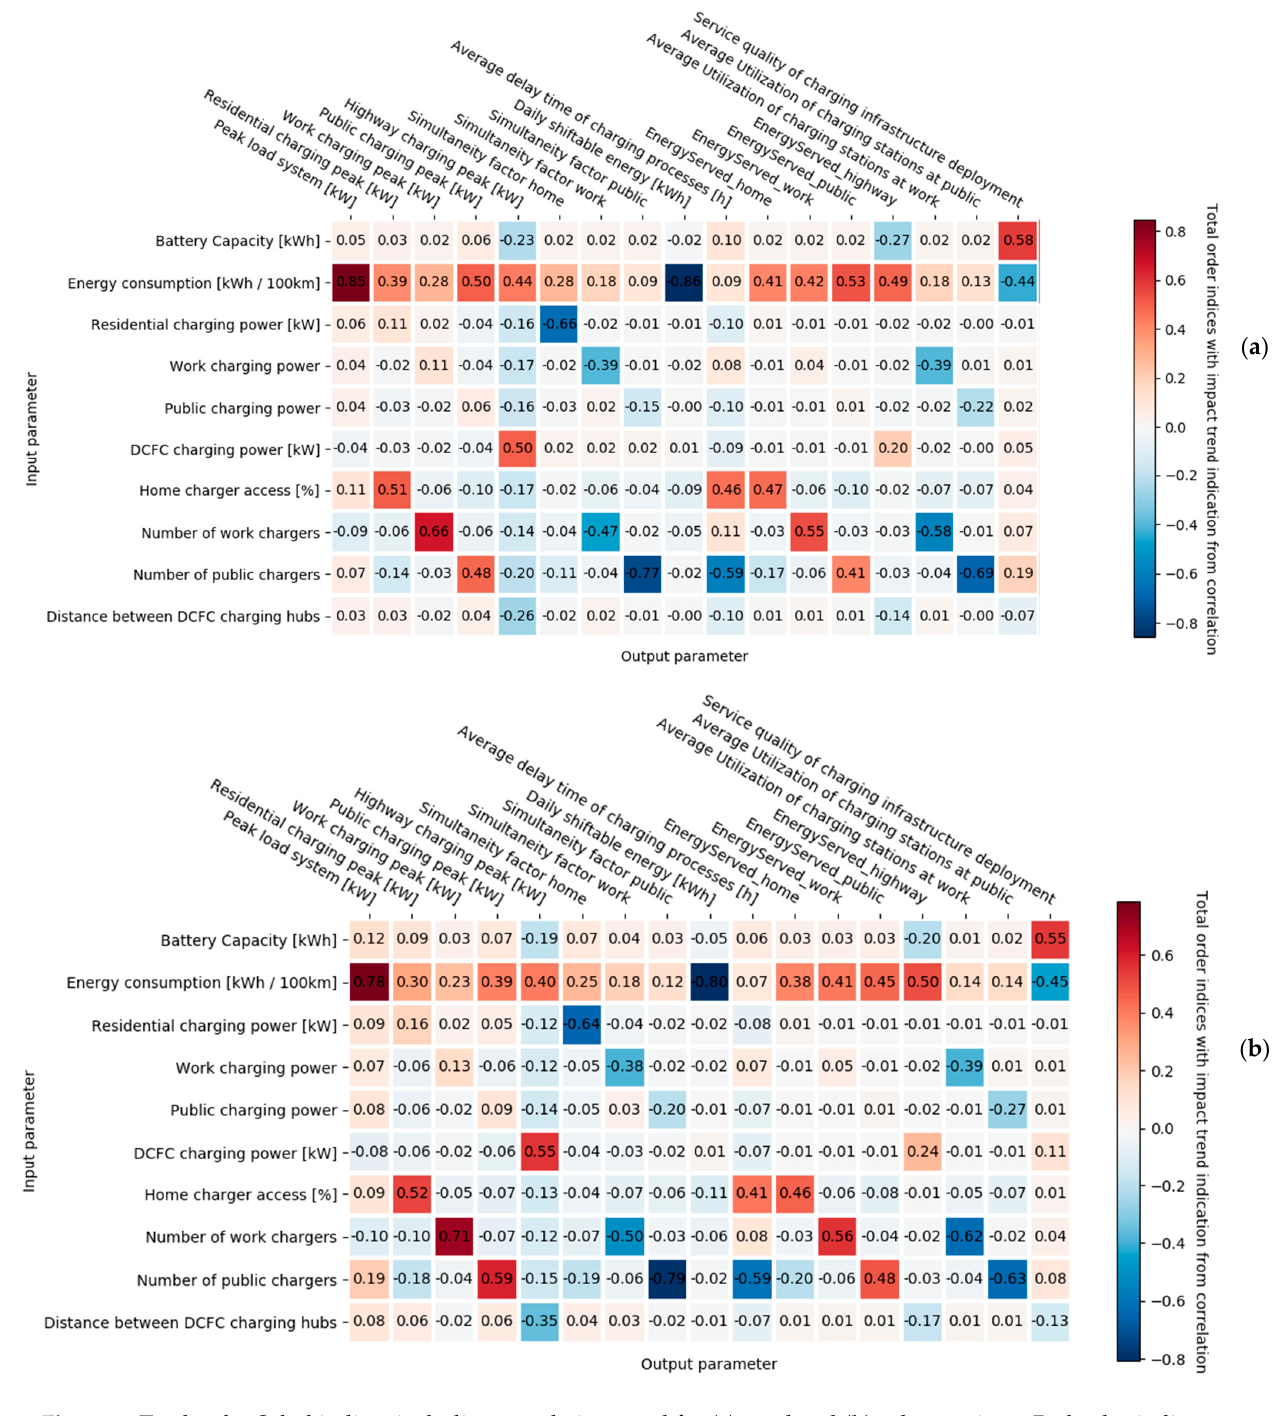
Figure 6. Total order Sobol indices including correlation trend for ( a ) rural and ( b ) urban regions. Red color indicates a positive correlation between input and output parameter; blue color indicates a negative correlation. Units in the input and output variable names are only for better understanding of the parameters but are not directly related to the total order Sobol indices’ values in this figure.